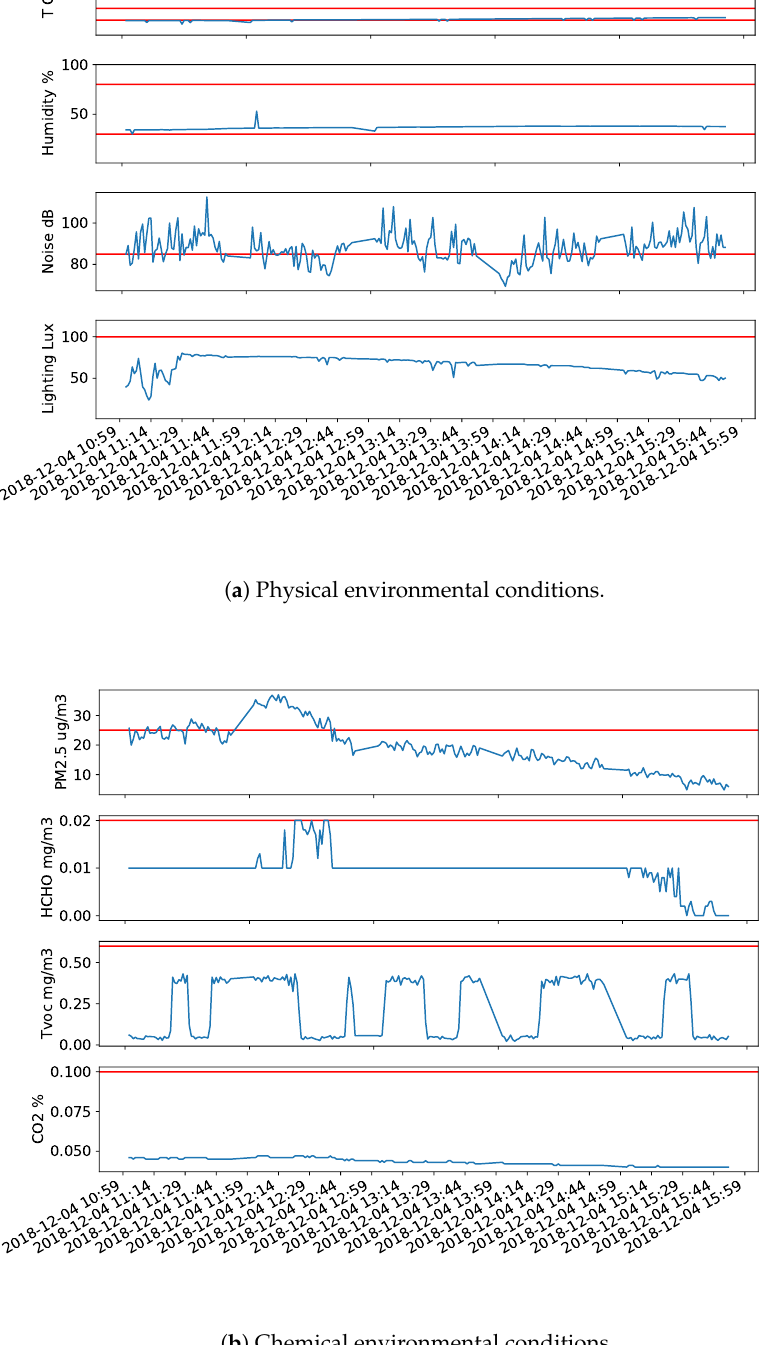
( b ) Chemical environmental conditions. Figure 6. Operator exposure to the environmental condition on site. The red line refers to the threshold limit value